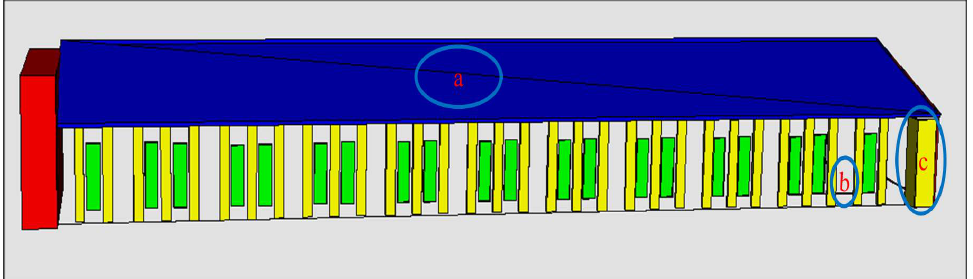
(c) Automatic reconstruction of a single-floor building model with Rule Set 2 . Compared with the reference